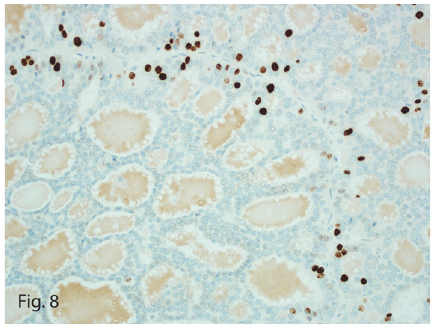
Figure 8: Ki-67 expression in the tumor cells (2% mitotic labeling index, original magnification ×